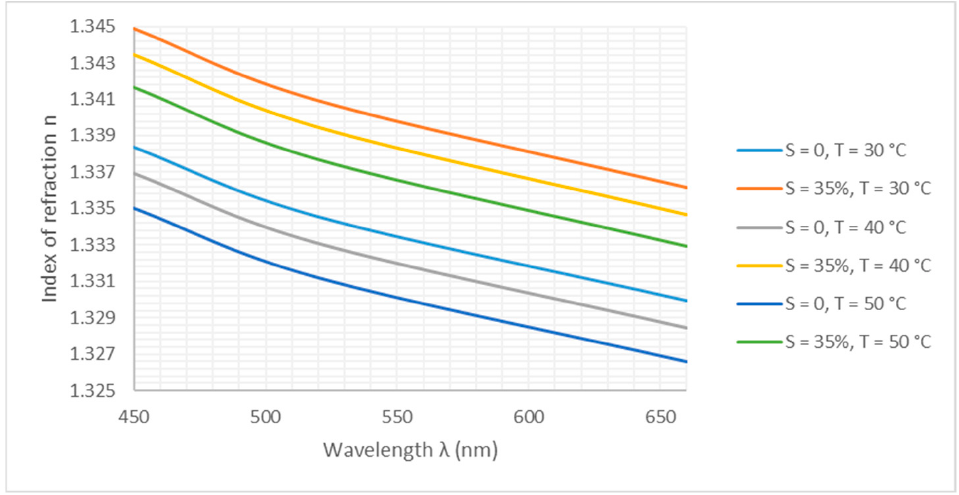
Figure 3. Refractive index vs. Wavelength for pure water and salt water at different temperatures. Data collected from COMSOL, for the distance d , can be easily verified using Snell’s law and trigonometry by Equation (3).